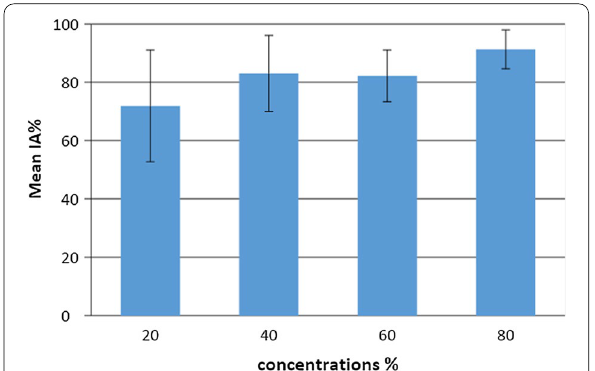
Fig. 1 Pupation inhibition effect of tyrosinase against Culex pipiens third-instar larvae